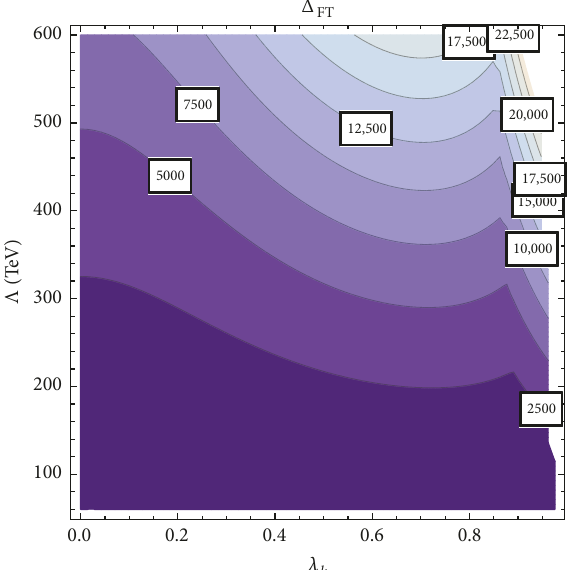
Figure 3: Distribution of fine-tuning measure in [𝜆 ℎ ,Λ] plane.